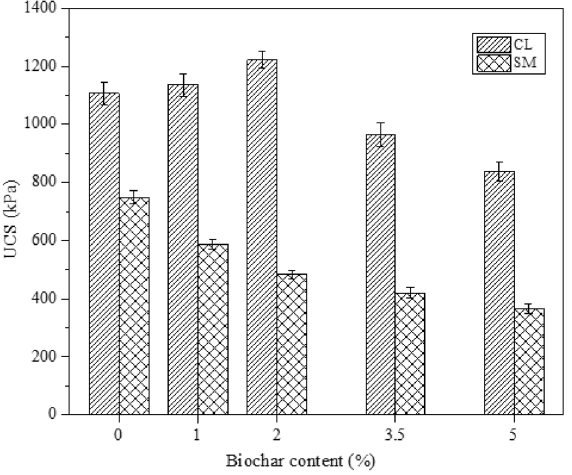
Figure 6. The effect of biochar increment (from 0 to 5% (w/w)) on UCS value of CL and SM